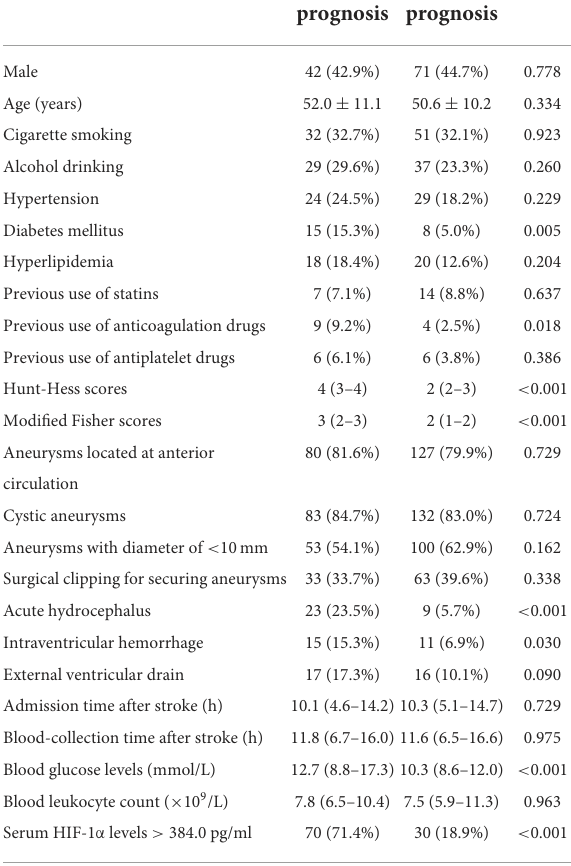
TABLE 4 Factors in correlation with 6-month poor prognosis following aneurysmal subarachnoid